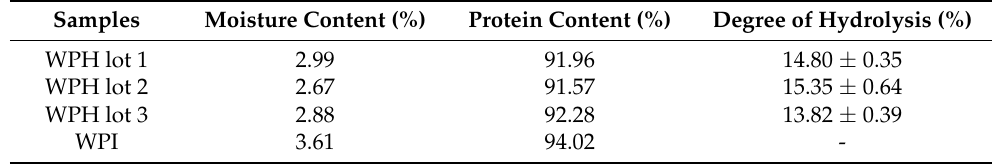
Table 1. Moisture content (%), protein content (%), and degree of hydrolysis of WPH and WPI samples. Samples Moisture Content (%) Protein Content (%) Degree of Hydrolysis (%) WPH lot 1 2.99 91.96 WPH lot 2 WPI 3.61 94.02